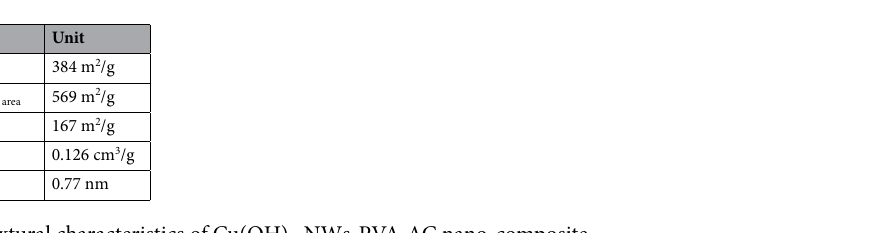
Table 1. Textural characteristics of Cu(OH) 2 -NWs-PVA-AC